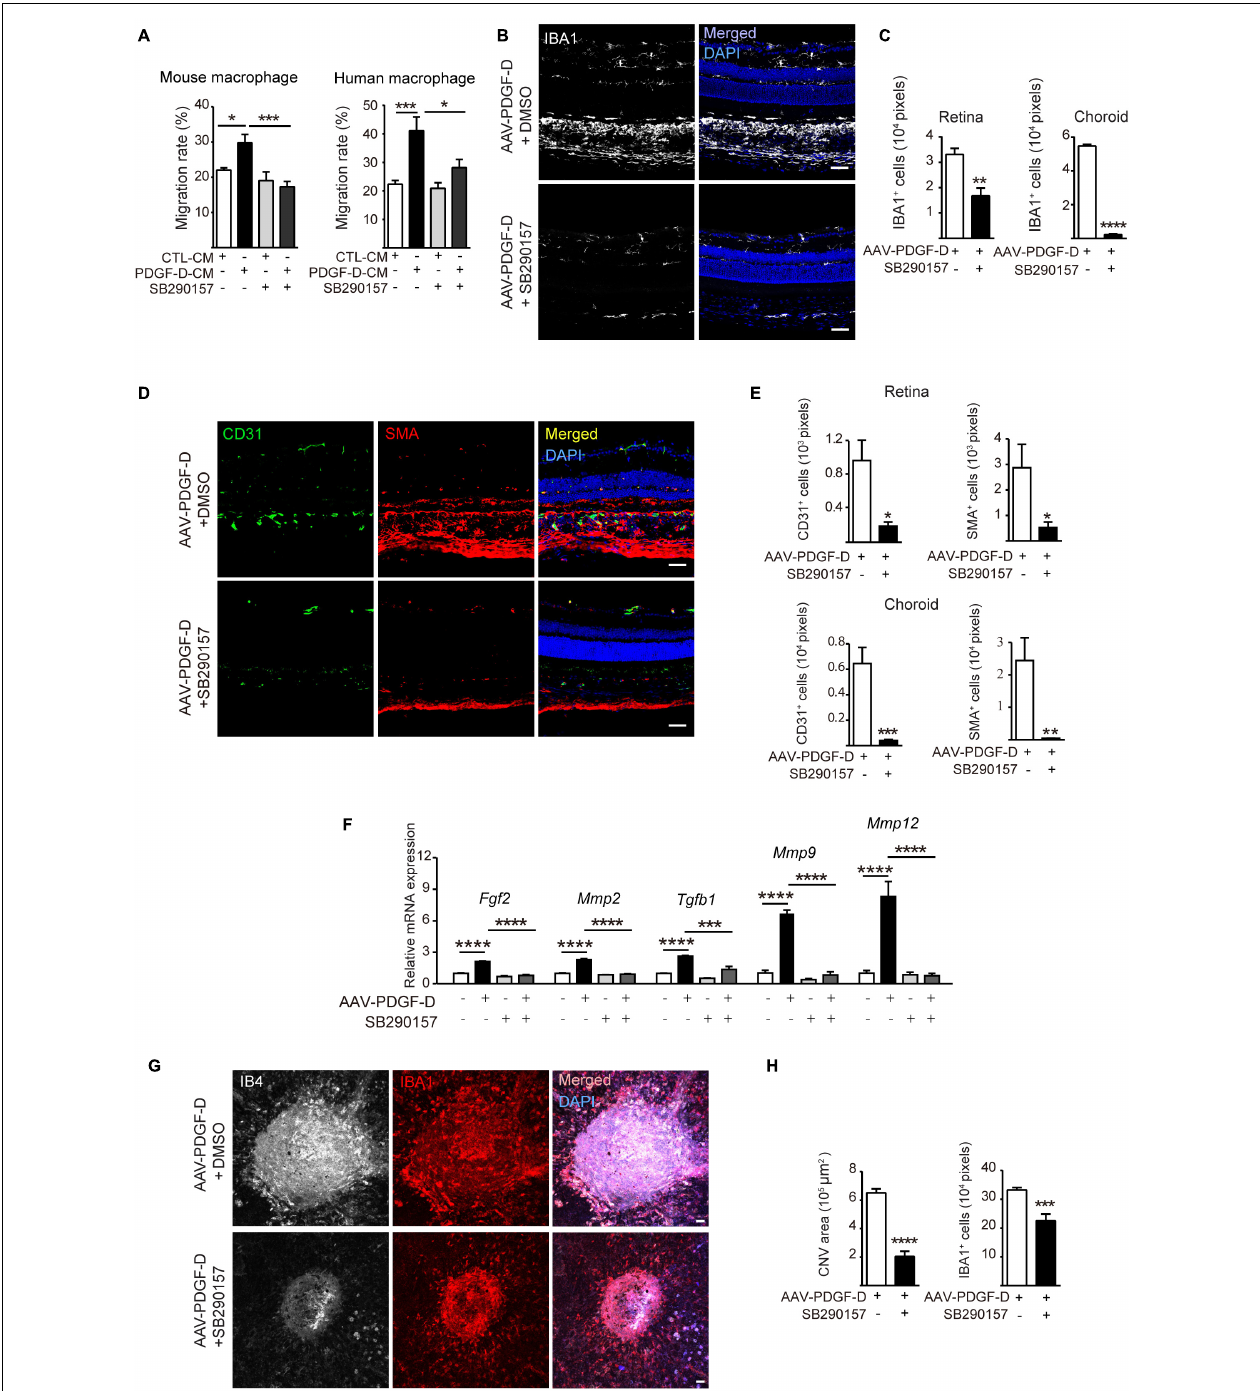
FIGURE 7 | Inhibiting complement C3 cascade by SB290157 alleviates PDGF-D-induced inflammation and pathological neovascularization. (A) SB290157 (20 µ M) inhibited migration of mouse and human macrophages treated with conditioned medium from PDGF-D-treated HRPE cells (PDGF-D-CM) for 24 h. Conditioned medium from HRPE cells without PDGF-D treatment (CTL-CM) was used as a control. (B) Immunofluorescence staining of IBA1 + macrophages in PDGF-D-overexpressing RPE-choroids treated with or without SB290157. (C) Quantification of IBA1 + macrophages in retinae and choroids in (B) . (D) Immunofluorescence staining of CD31 + ECs, NG2 + pericytes and α -SMA + SMCs in PDGF-D-overexpressing RPE-choroids treated with or without SB290157. (E) Quantification of the CD31 + , SMA + , and NG2 + cells in retinae and choroids in (D) . (F) Real-time PCR results showing that SB290157 inhibited PDGF-D-induced upregulation of angiogenic genes. (G) RPE-choroid wholemount immunofluorescence staining showing SB290157 reduced IB4 + neovessels and IBA1 + macrophages in laser-induced CNVs with AAV-GFP or AAV-PDGF-D overexpression. (H) Quantification of IB4 + and IBA1 + cells in (G) . Scale bar: 50 µ m. n = 6, * p < 0.05, ** p < 0.01, *** p < 0.001, **** p < 0.0001.